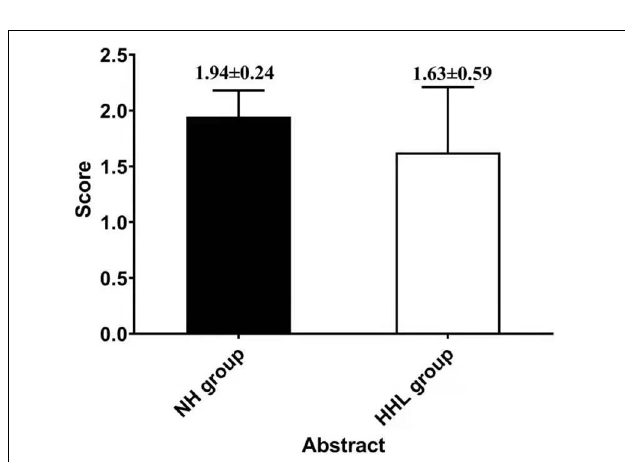
FIGURE 2 | The difference in abstract ability between the HHL and NH groups.